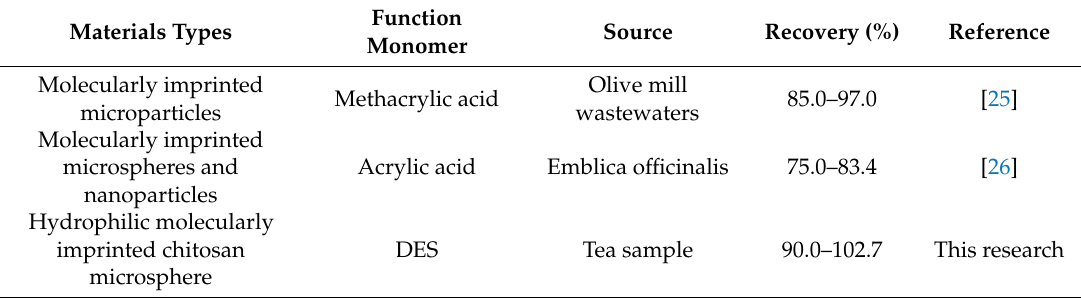
Table 2. Comparison of di ff erent materials for extraction of GA.